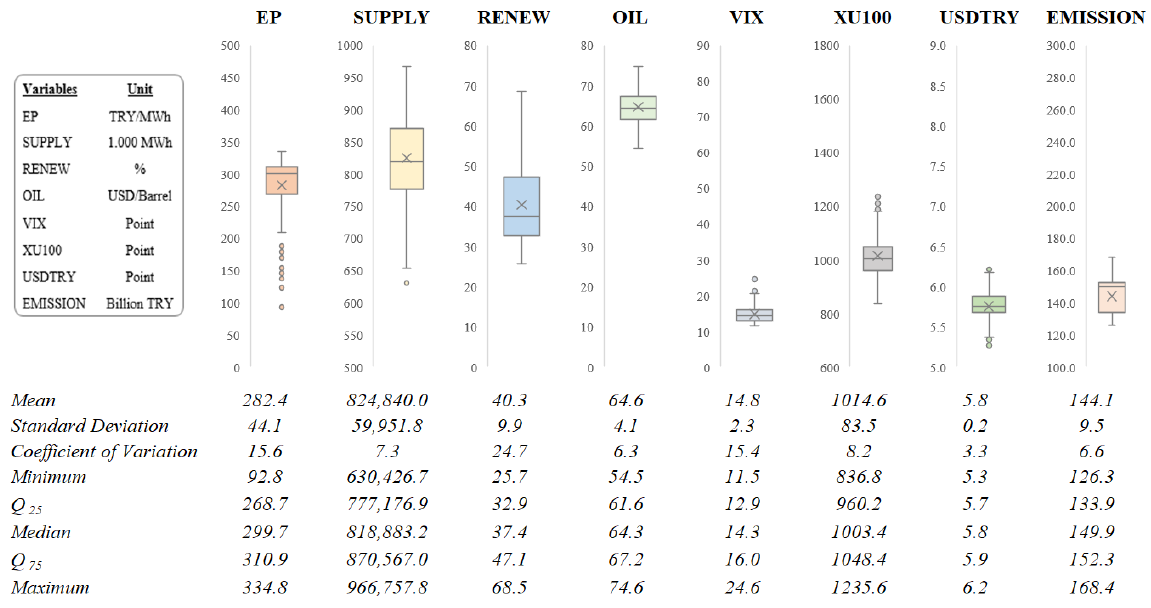
Figure 2. Descriptive statistics in the pre-pandemic period (15 February 2019 –10 March 2020) .